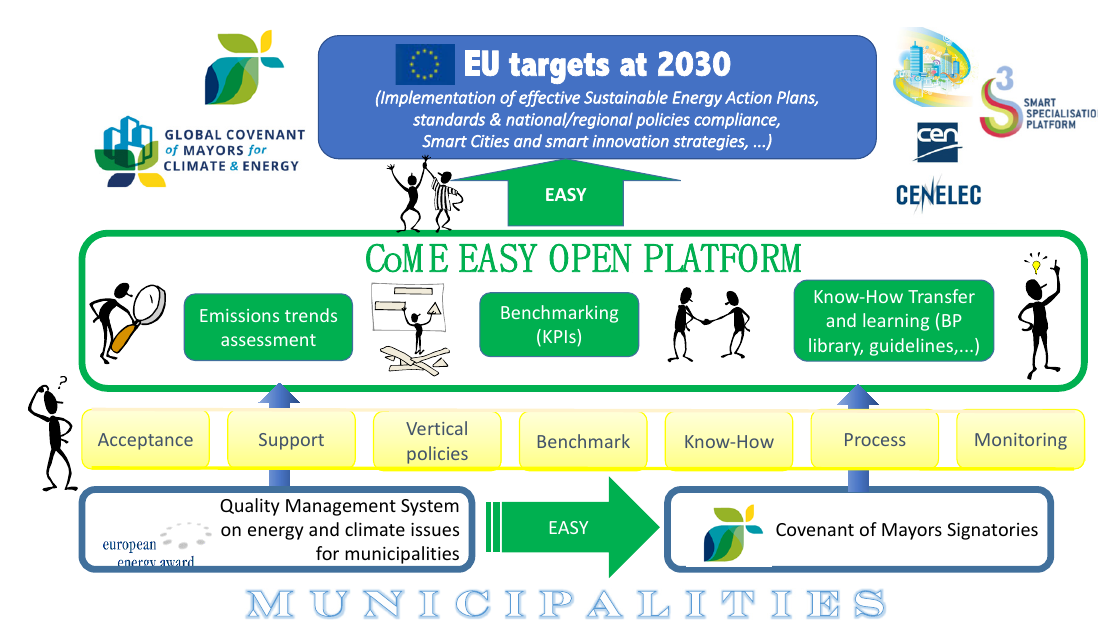
Figure 2. The CoME EASY Open Platform.